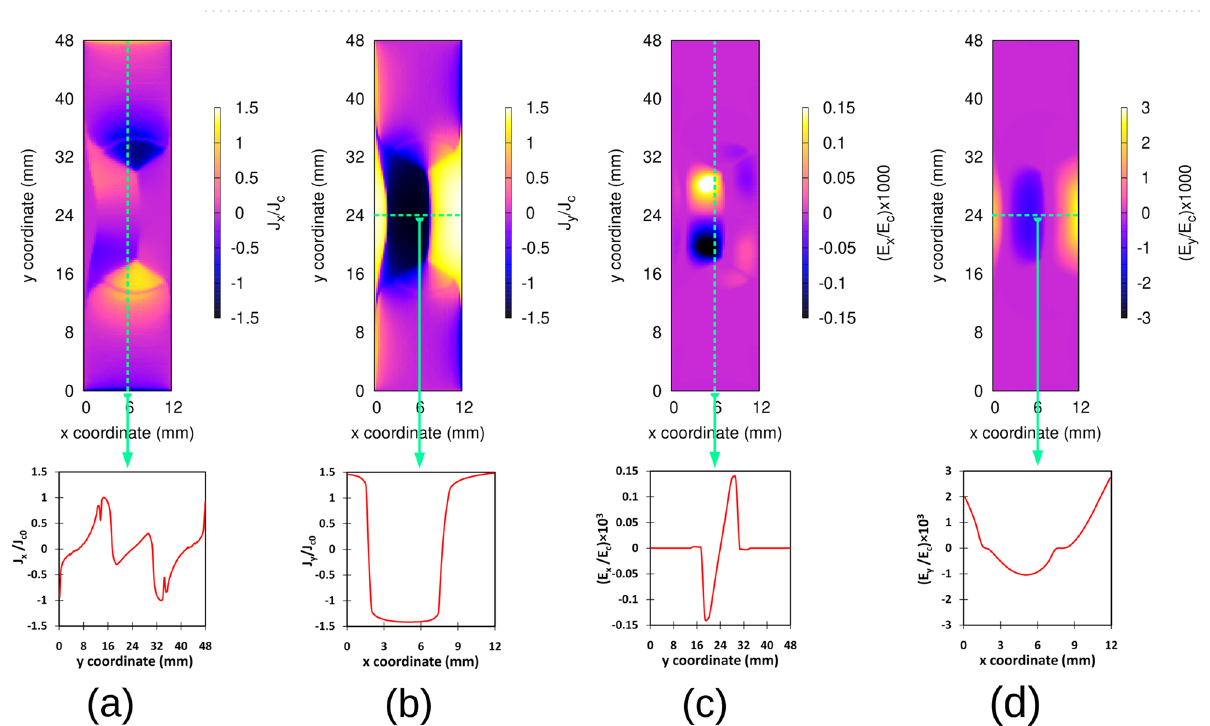
Figure 6. Modeling results for the x and y components of current density and electric field while the magnet is just on the top and concentric to the tape (step C in Figs. 4 and 5) for airgap 3.3 mm and constant J c , ( a ) J c -normalized current map and current profile of J x along the y axis in the middle of the tape (dashed green line), ( b ) J c -normalized current map and current profile of J y along the x axis in the middle of the tape (dashed green line), ( c ) E c -normalized electric field map and electric field profile of E x along the y axis in the middle of the tape (dashed green line), ( d ) E c -normalized electric field map and electric field profile of E y along the x axis in the middle of the tape (dashed green